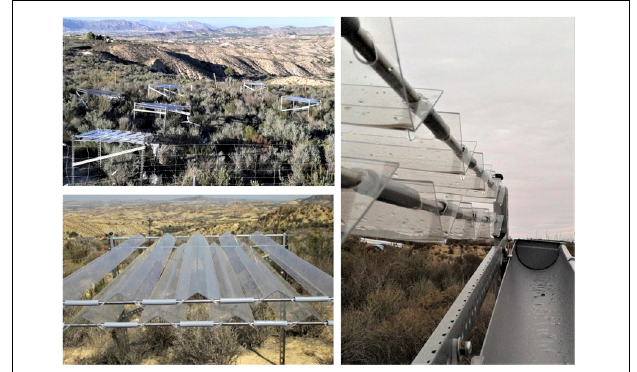
FIGURE 4 | General view of the drought-stress experiment in Albatera-Santomera (above left) and details of a roofed-control plot (bottom left) and a closer view on the roof with the gutter that captures the excluded rainfall (right)